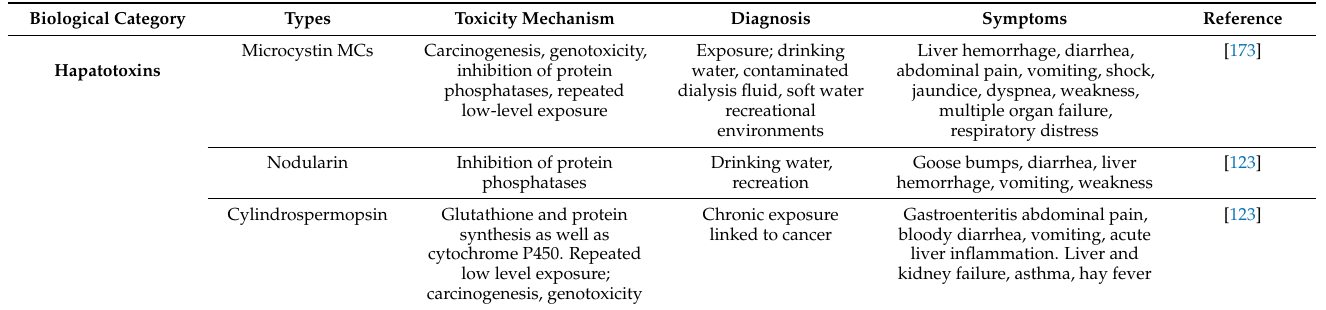
Table 2. The scientific consensus on phycotoxins by harmful algal blooms (HABs), the toxicity mechanism, diagnosis, and negative effects on human